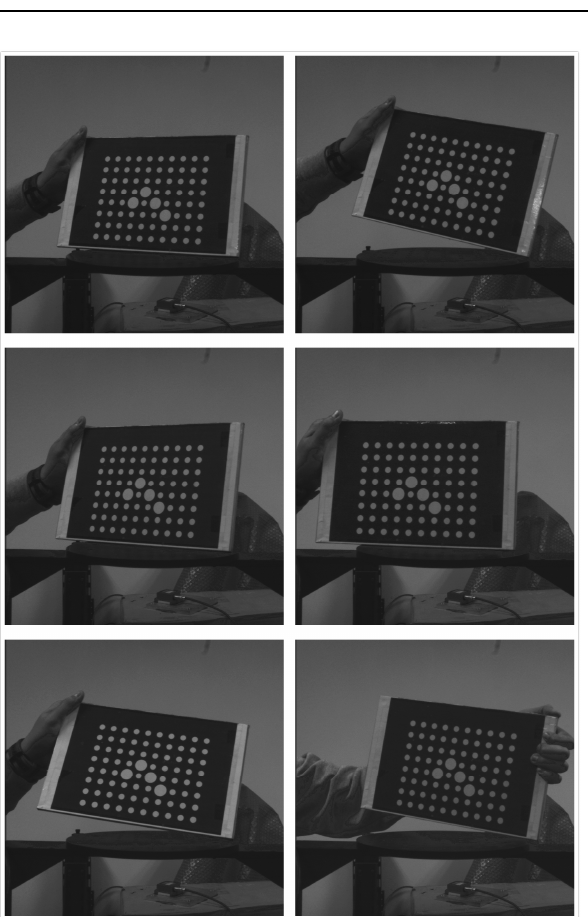
Figure 8. The image of P 0 , P 1 , P 2 , and P 3 on the calibration board.